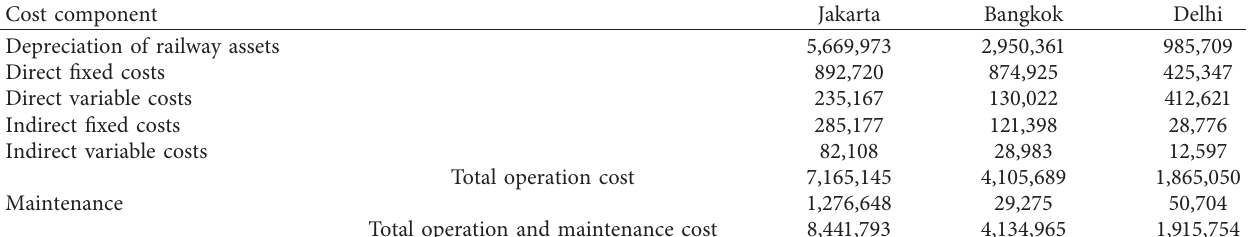
Table 3: Operation and maintenance cost per kilometer per year comparison (in USD).